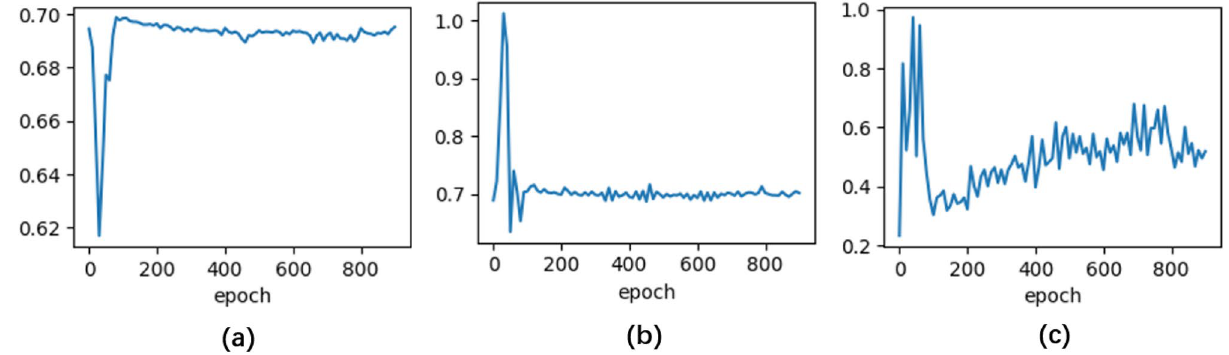
Figure 4. Training process of the proposed 3D DCGAN. ( a ) The loss of D ( b ) the loss of G ( c ) the output of D.